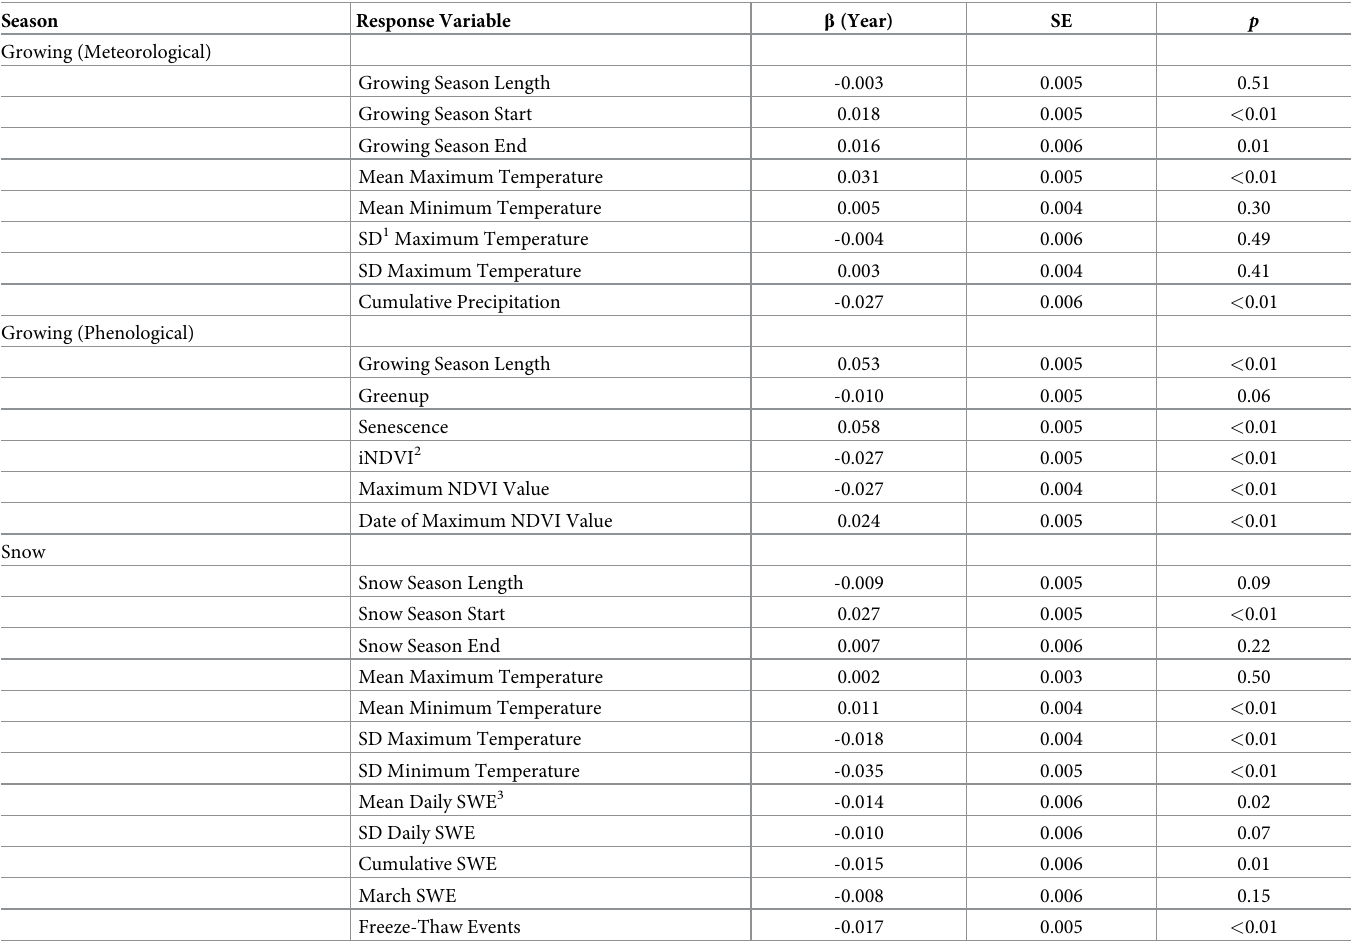
Table 1. Estimated temporal trends in variables used to assess the demographic response of woodland caribou to annual meteorological and phenological variation.